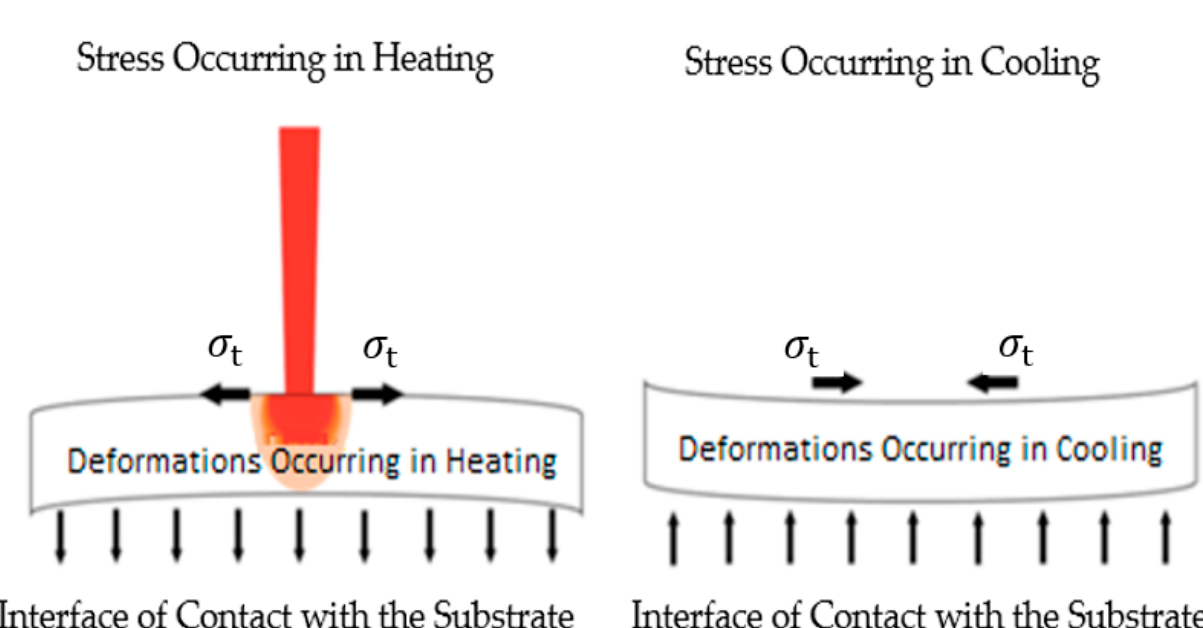
Figure 2. Stress gradients in one layer [7].